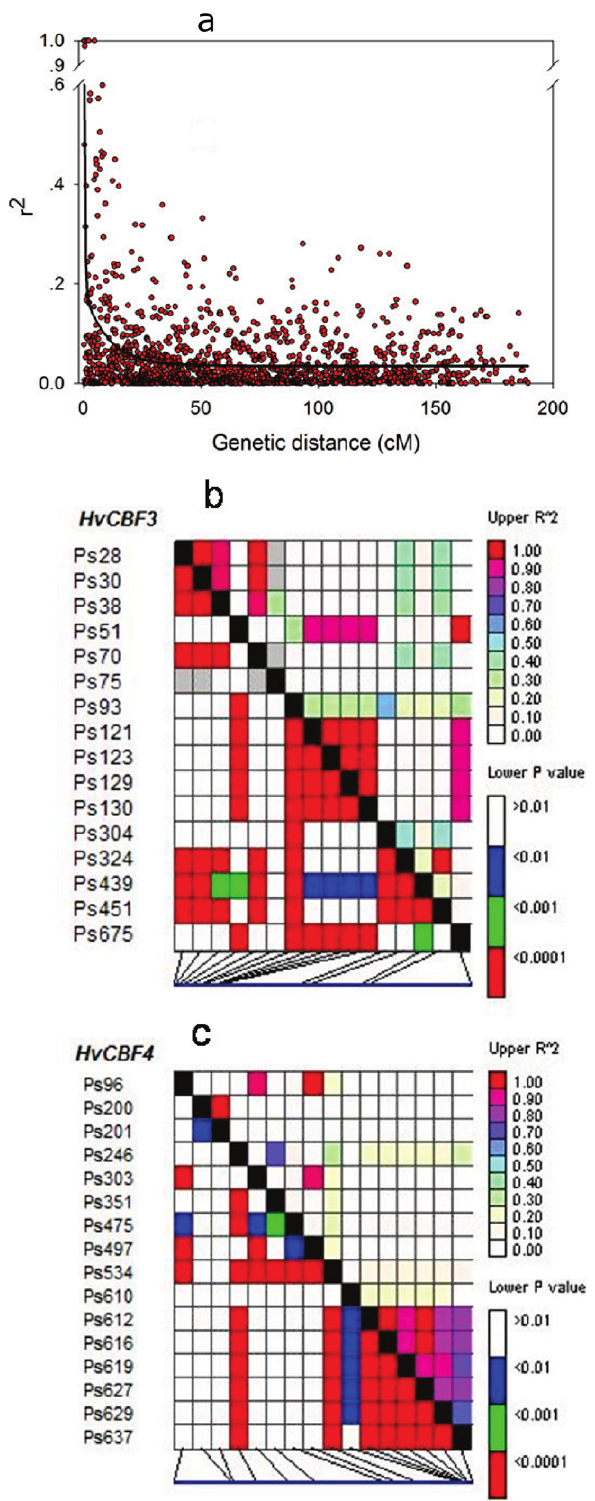
Figure 4. Decay of linkage disequilibrium (LD) of chromosome 5 and intragenic linkage disequilibrium of HvCBF genes in Tibetan barley. (a) Decay of linkage disequilibrium of chromosome 5 based on 57 DArT markers, the decay of genetic distance is 8.9 cM (r 2 =0.1). The data was fitted to a five-parameter exponential decay model: y=0.0351 + 0.9098e ( 2 2.5845x) + 0.1536e ( 2 0.0966x) (b) intragenic link- age disequilibrium of the HvCBF3 gene. (c) intragenic linkage